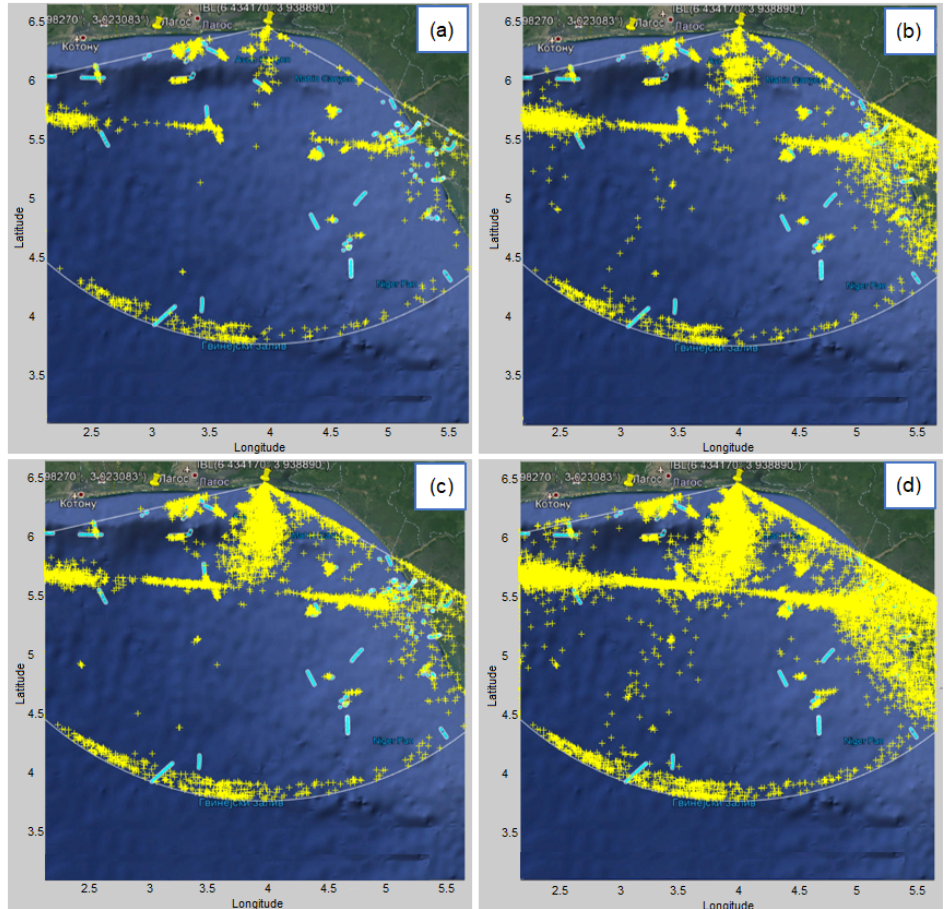
Figure 20. The display of all vessel’s detections (yellow markers) with AIS data as a benchmark (light blue tracks) in a time interval of 1 h (17–18 pm) for different detection parameters of the proposed algorithm: ( a ) K = 5 and normalized threshold = 0.2 ( b ) K = 5 and normalized threshold = 0.1 ( c ) K = 10 and normalized threshold = 0.2 ( d ) K = 10 and normalized threshold =